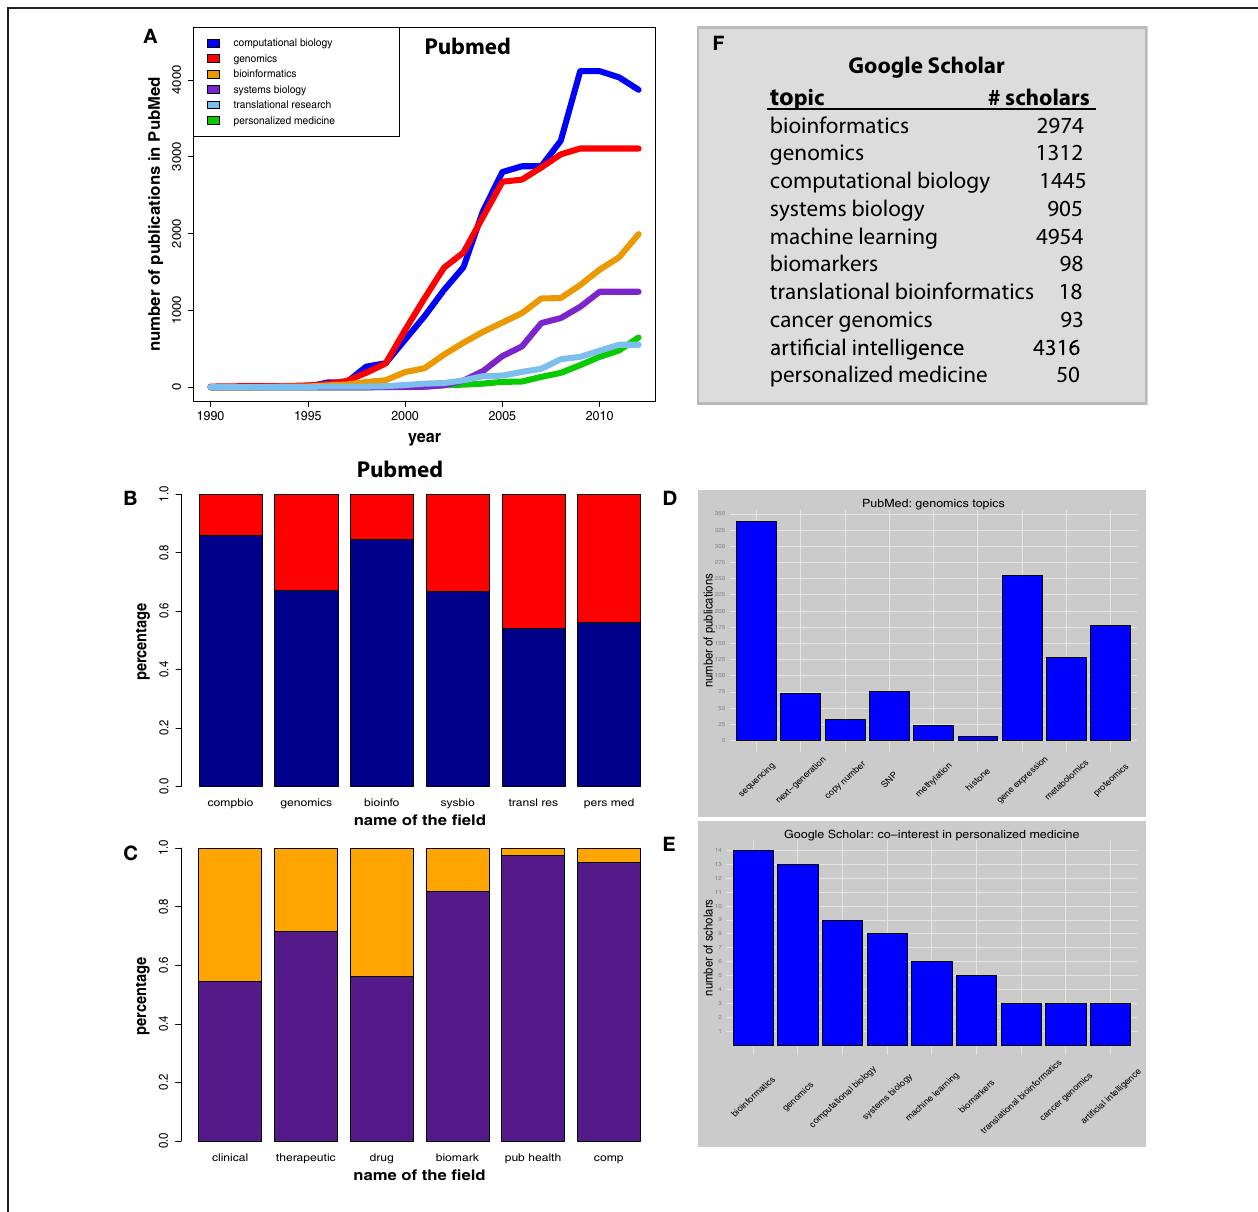
“topic” (on the x-axis) and purple corresponds to all remaining publications. (D) Distribution of genomics data types, shown on the x-axis. (E) People interested in personalized medicine are also interested in the topics on the x-axis. (F) Numbers of scholar interested in the listed